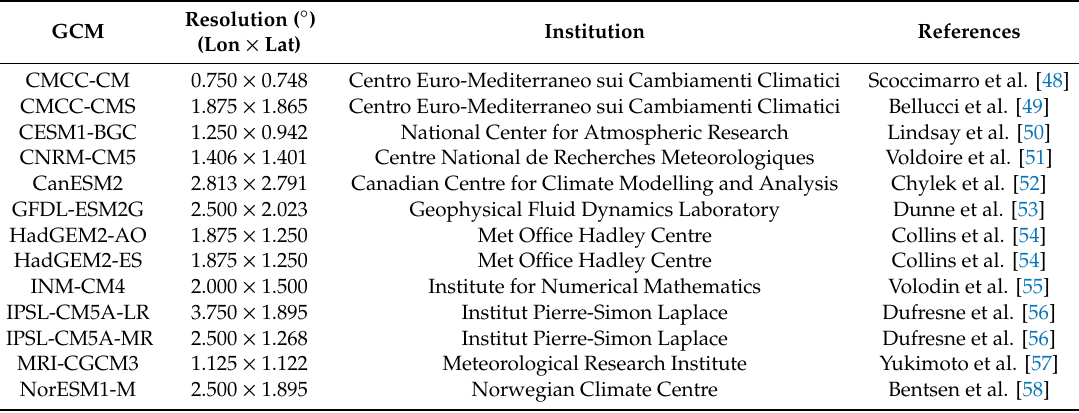
Table 3. The CMIP5 general circulation model (GCM) downscaled data used in this